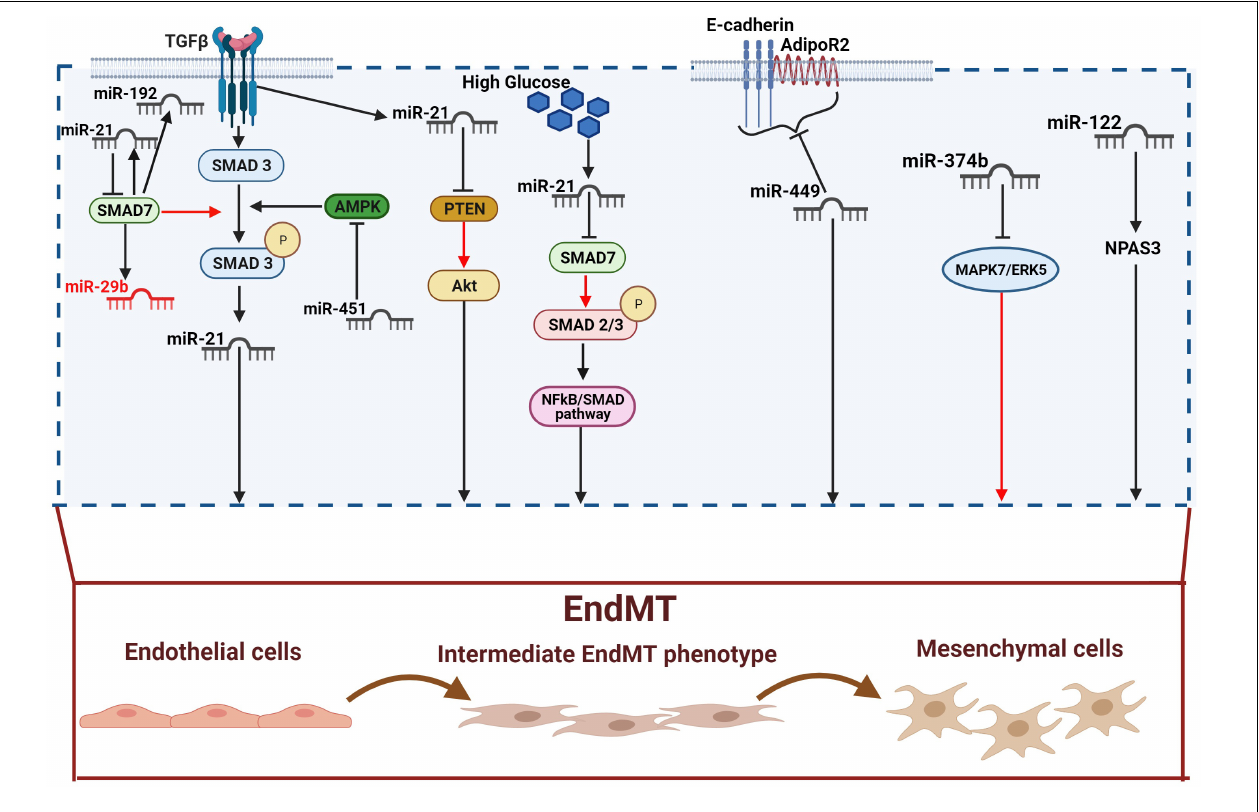
FIGURE 2 | Pro-fibrotic miRNAs in diabetic complications. TGF- β increases miR-21 expression through Smad3 activation. miR-21 expression is also directly increased by TGF- β and high glucose. miR-21 can in turn activates EndMT through releasing PTEN of Smad7 inhibition (red arrow). Indeed, both PTEN and SMAD7 are negative regulators of EndMT via the Akt and TGF- β 1/Smad3 signaling respectively. SMAD7 can also suppress fibrosis by down-regulating the pro-fibrotics miR-21 and miR-192, and up-regulating the anti-fibrotic miR-29b. miR451 triggers EndMT by blocking AMPK, an inhibitor of the TGF- β /SMAD pathway. miR-449a induces EndMT by inhibiting AdipoR2 and E -cadherin interaction in the lipid rafts. miR-374b plays its profibrotic activity by releasing MAPK7/ERK5-mediated EndMT inhibition. Finally, miR-122 activates EndMT via the neuronal PAS domain protein 3 (NPAS3). Pro-fibrotic miRNAs are shown in dark, anti-fibrotic miRNAs in red. TABLE 2 | Pro-fibrotic miRNAs in diabetic